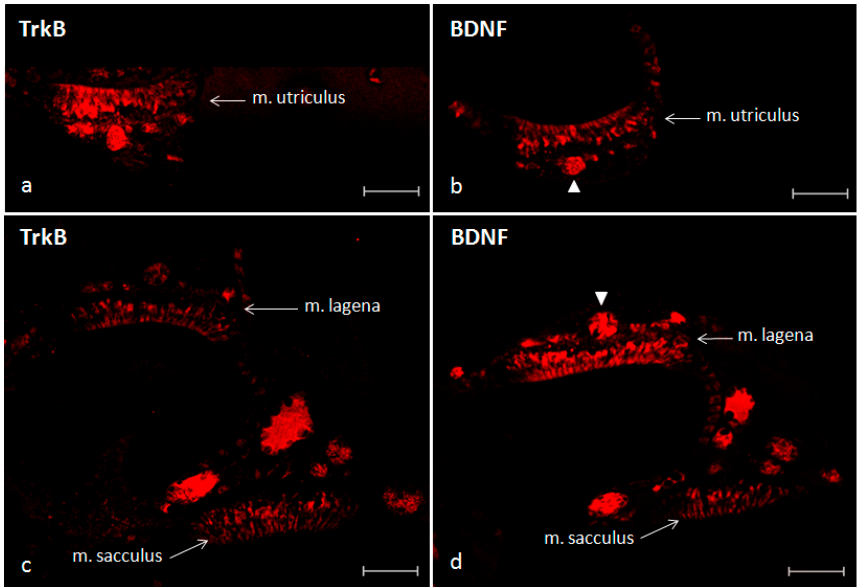
Figure 8. Inner ear of adult zebrafish. Immunohistochemical localization of TrkB ( a ) and BDNF ( b ) in the macula of the utricle. Immunohistochemical localization of TrkB ( c ) and BDNF ( d ) in the macula of the lagena and saccule. Arrowheads in ( b , d ) indicate nerves. Scale bars = 50 μ m.